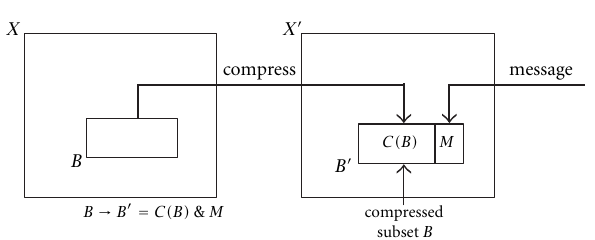
Figure 1: Diagram for lossless data embedding using lossless com-